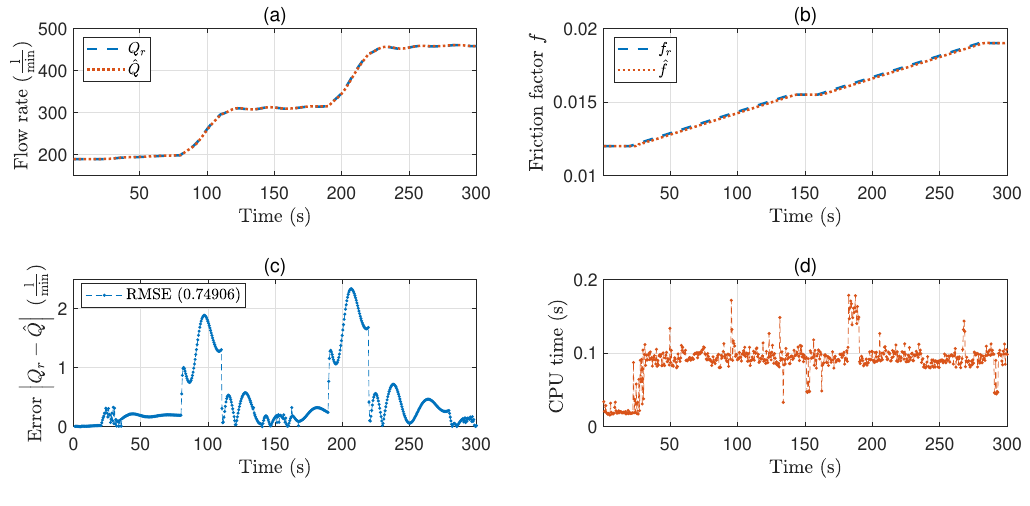
Figure 8: (a) The actual (subscript r) and estimated fluid flow rate (b) the actual and estimated Fanning friction factor (c) the absolute error between the actual and estimated flow rates and (d) the CPU time t taken for each time step (the actual time step is 0.5 s) are plotted